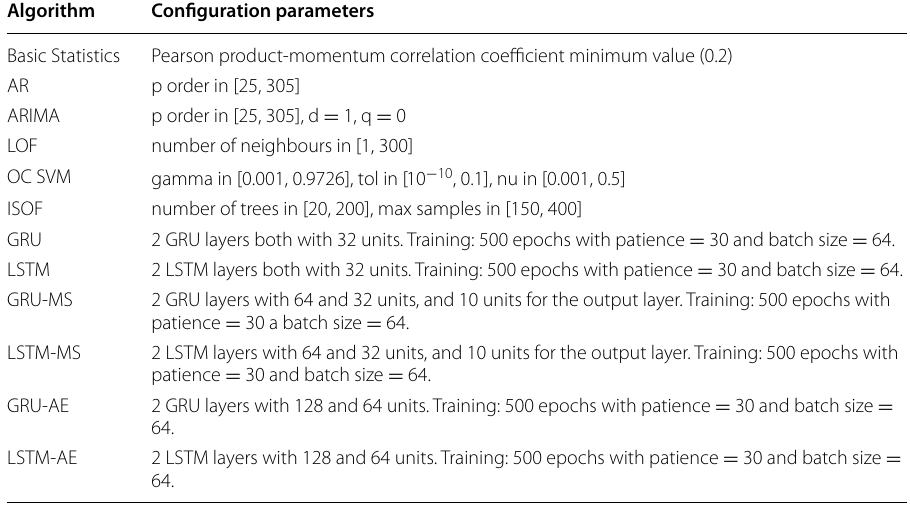
Table 3 Relevant configuration parameters of the compared